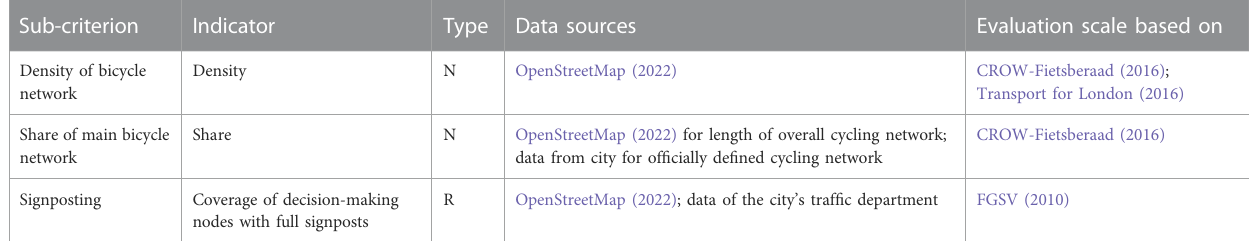
TABLE 5 Coherence: sub-criteria, indicators, type of indicators (E: edge-based, R: route-based, N: network-based), data sources and sources for evaluation scales.